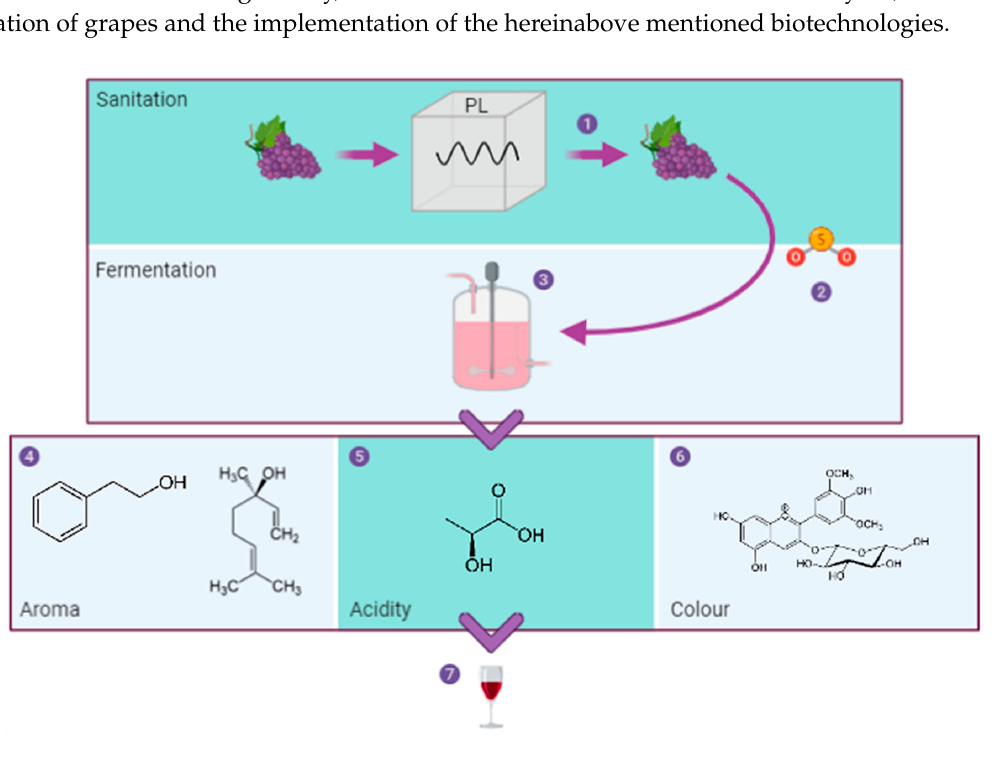
Figure 5. Summary of the potential benefits of using PL sanitation on grapes in the winemaking industry. ( 1 ) Inactivation or elimination of microbial population, ( 2 ) less usage of SO 2 , ( 3 ) use of selected non- Saccharomyces yeasts, ( 4 ) enhance aroma profile, ( 5 ) modulate organic acidity, ( 6 ) increase pigment extraction and ( 7 ) gain freshness in wines towards customer